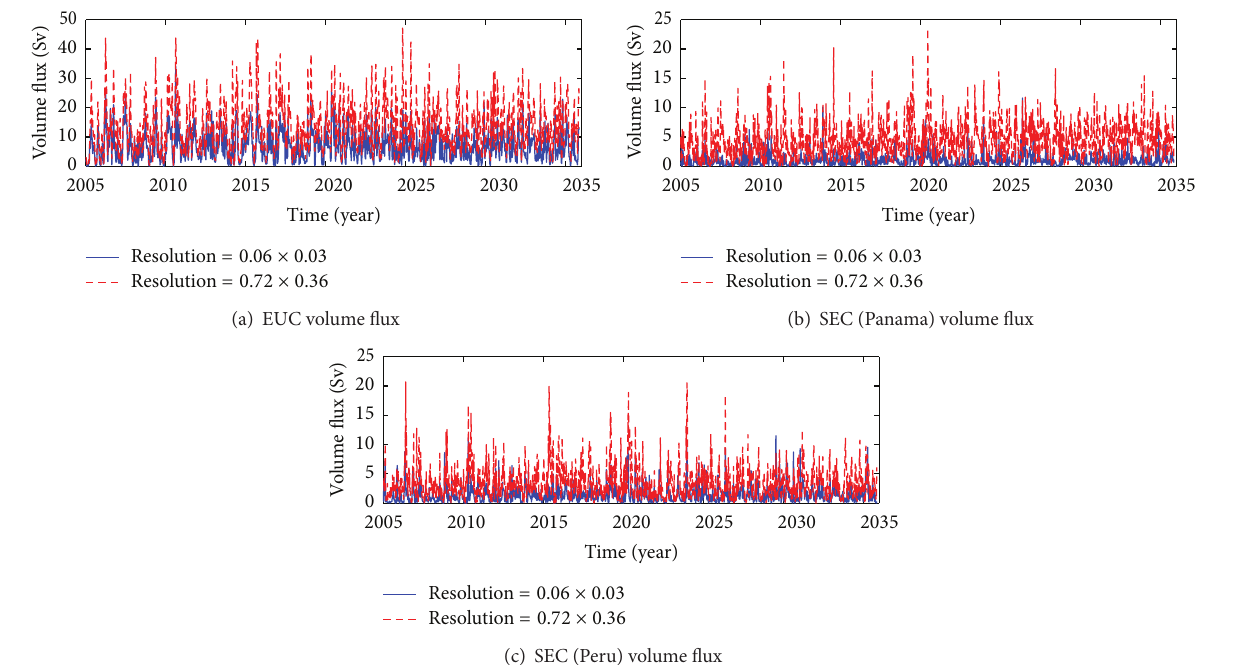
Figure 21: The simulated EUC, SEC (including the Panama current and the Peru current) volume flux transport from 2005 to 2035 around GMR. The solid line is the simulated flux transport with a high resolution of 0.06 ∘ × 0.03 ∘ , while the dashed line means the simulated flux transport with a relatively low resolution of 0.72 ∘ × 0.36 ∘